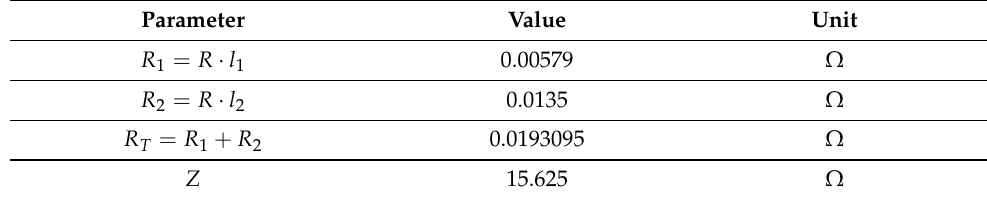
Table A4. Transmission line resistance and load impedance.